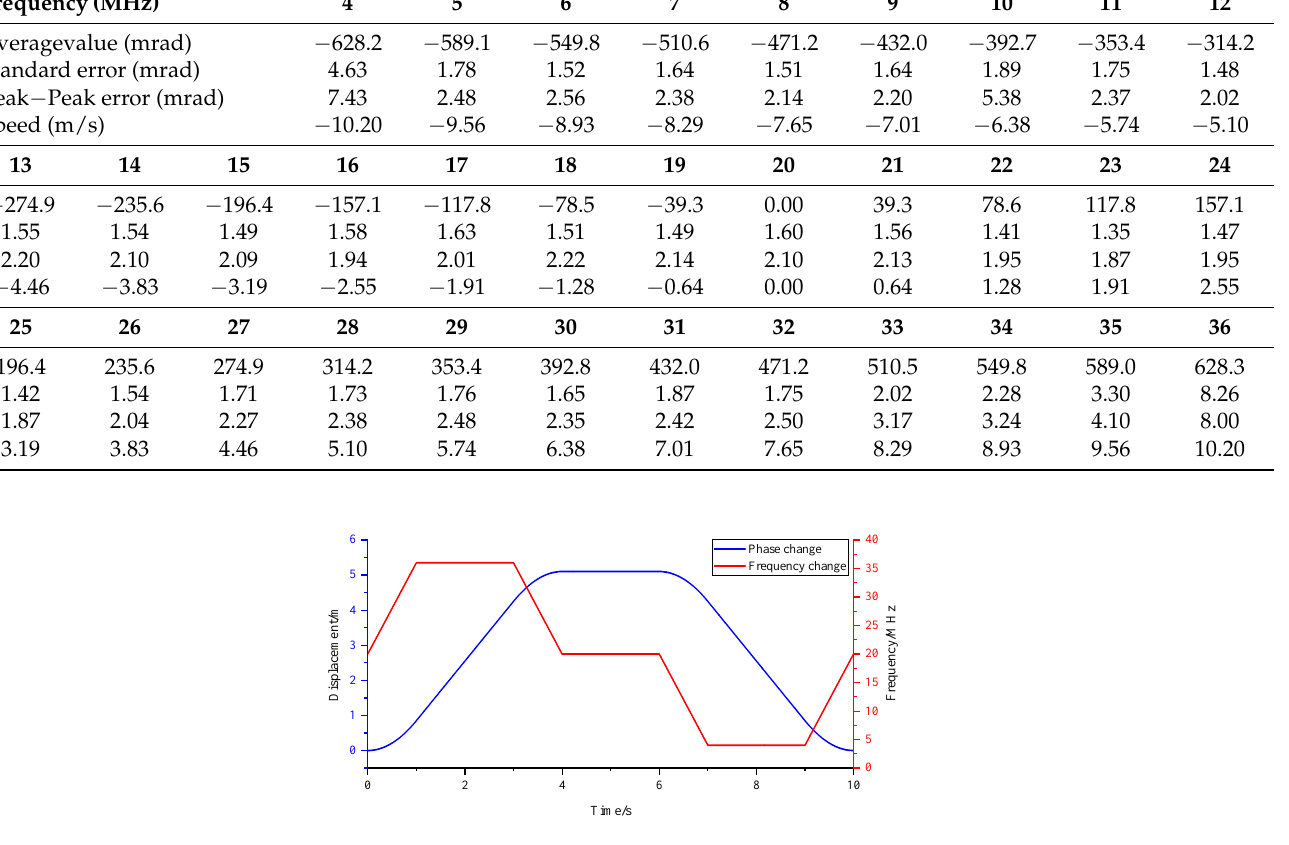
Figure 23. The displacement change calculated by the phase calculation algorithm with dynamic filter when the motion table accelerates and